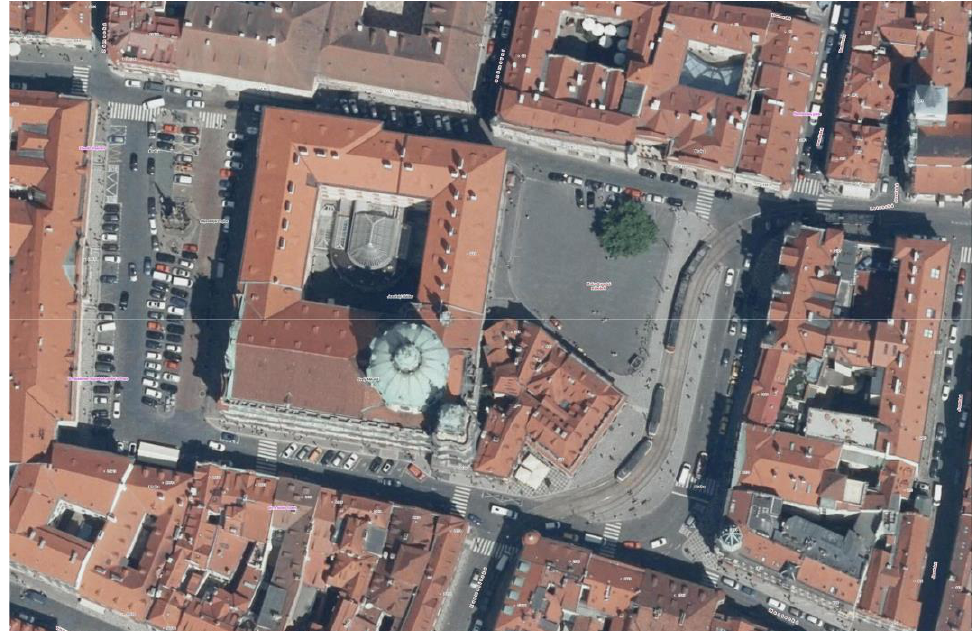
Figure 7. Lesser Town Square (aerial photograph) with the eastern and western parts.